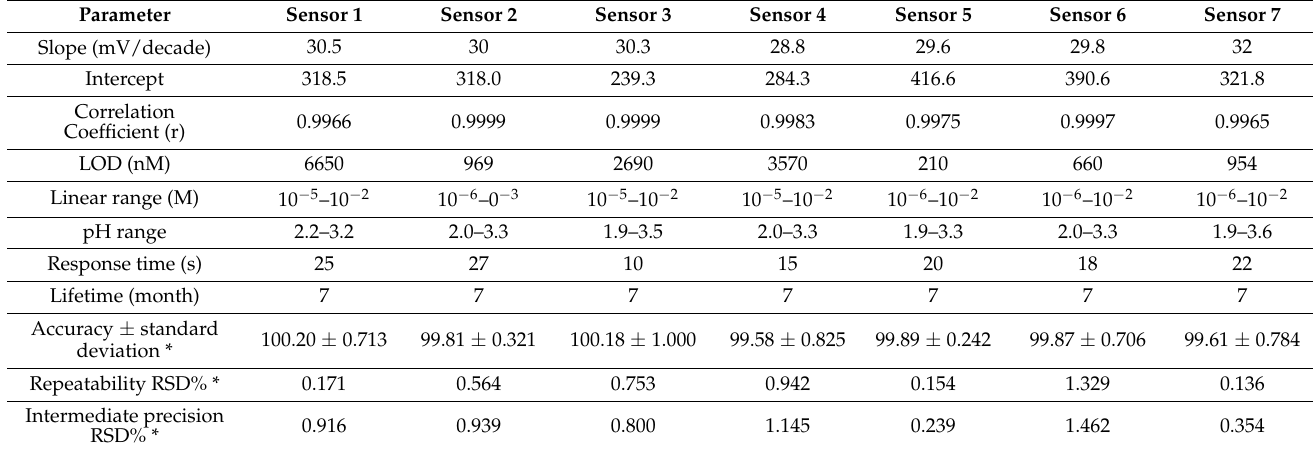
Table 2. Potentiometric performance characteristics of gemifloxacin screen-printed sensors.